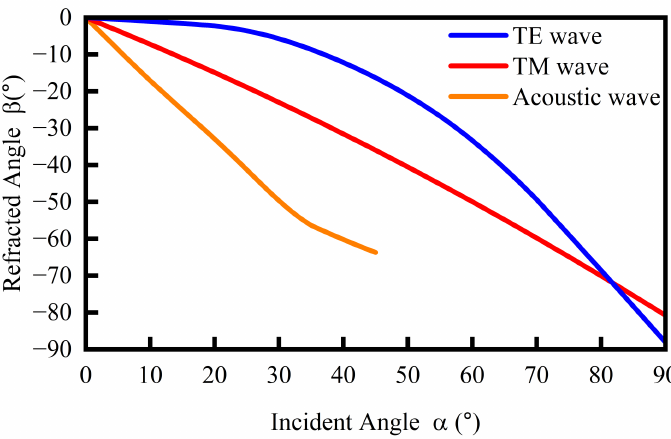
Figure 4. Dependence of refraction angle β on incident angle α .